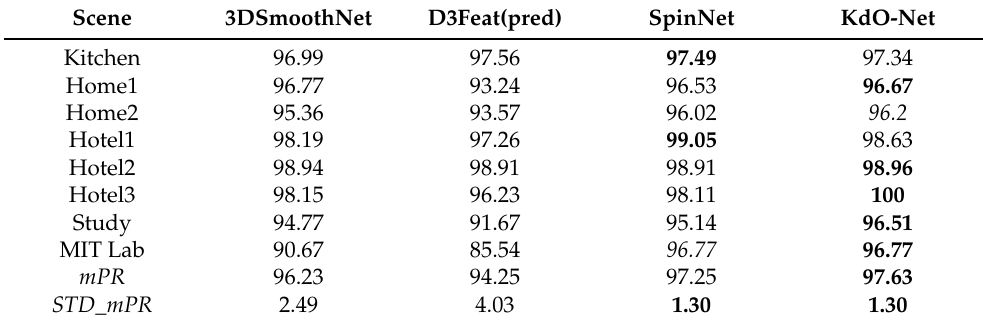
Table 4. Precision (%) of different reproduced models on each scene of BundleFusion , a subset of 3DMatch , with τ 1 = 10 cm and τ 2 = 0.05. The best performance is shown in bold. Scene 3DSmoothNet